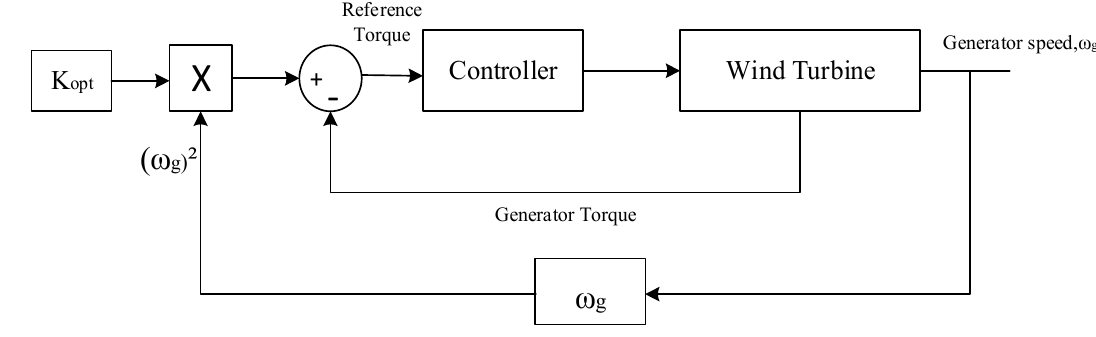
Figure 6. The block diagram of optimal torque control method.